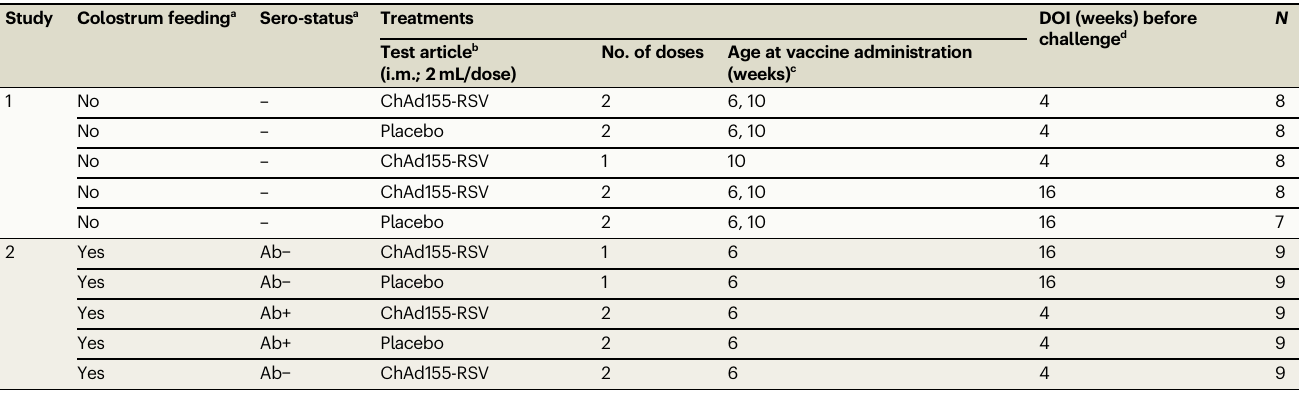
Table 1 | Detailed study designs Study Colostrum feeding a Sero-status a